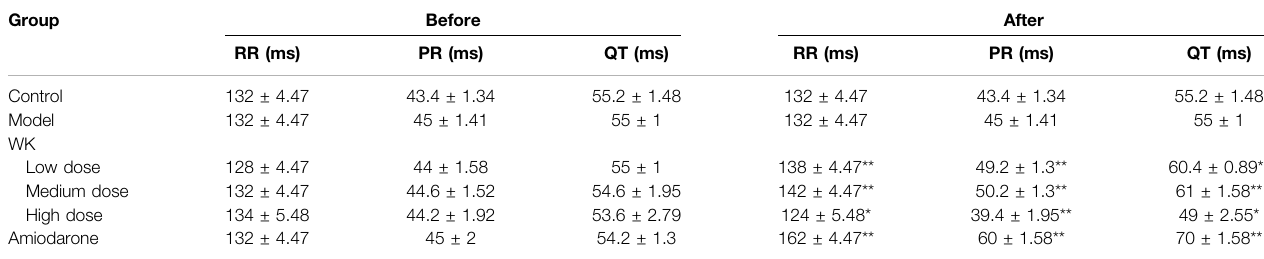
TABLE 5 | ECG parameters under the in fl uence of WK ( x ± s , n (cid:1) 8). Group Before After